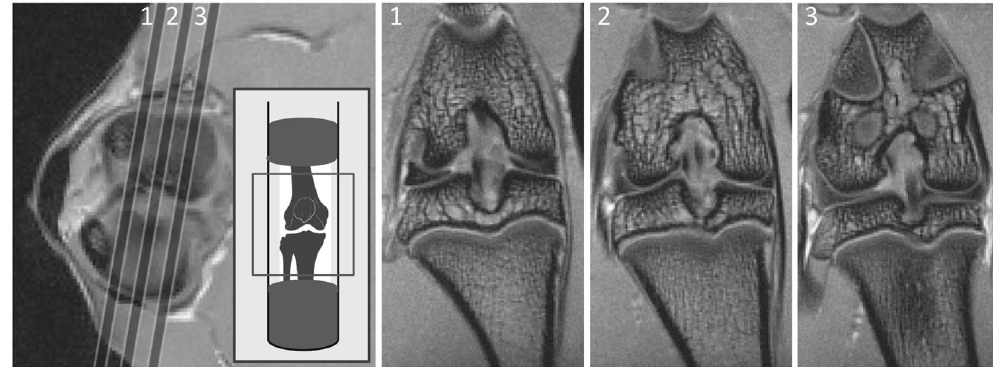
Figure 1. The MRI scan locations are shown in an axial slice of control knee joint. The position of coronal slice inside MRI gantry is shown in inset. Here 1, 2 and 3 refer to the anterior, central and posterior slices, respectively. These slice orientations were maintained for all scans of CTRL, MSX and CLAT joints. The femoral and tibial AC, the menisci, cortical and trabecular bone of the epiphysis, ligaments and fat tissues were clearly visible in the T 2 -weighted coronal slices acquired maintaining this protocol. The schematic outline of the knee in the inset is reproduced from https://en.wikipedia.org/wiki/Knee#/media/File:Knee_skeleton_lateral_ anterior_views.svg in accordance with the terms of the CC BY 2.5